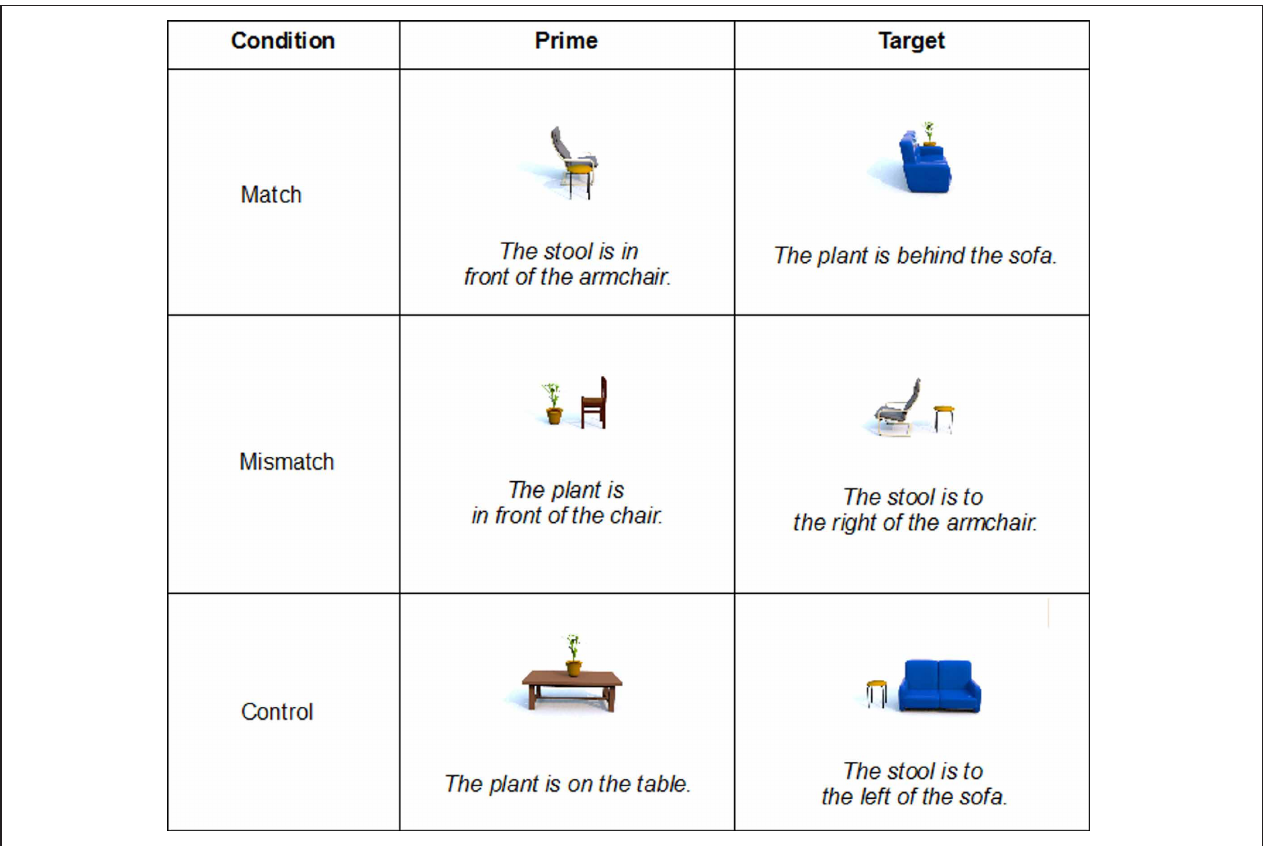
FIGURE 2 | Examples for prime-target-pairs in each